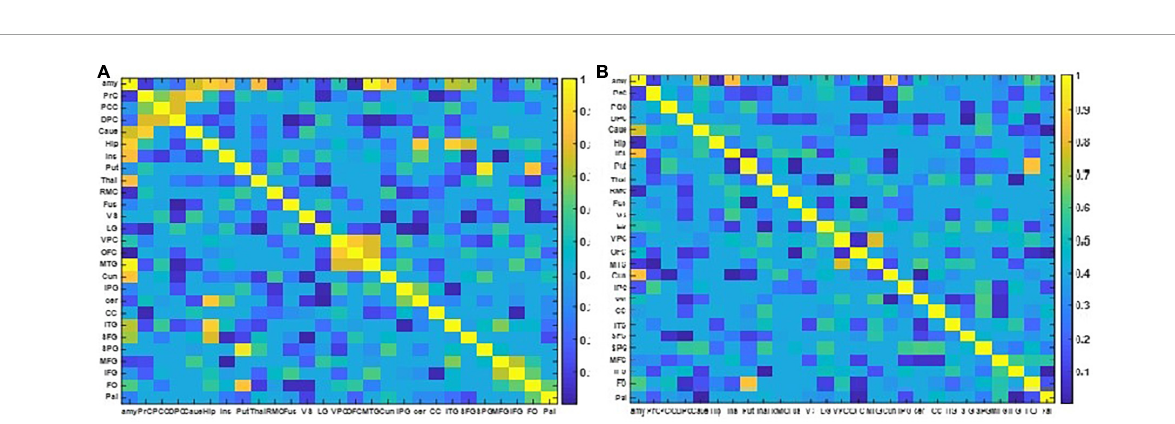
Frontiers in Human Neuroscience